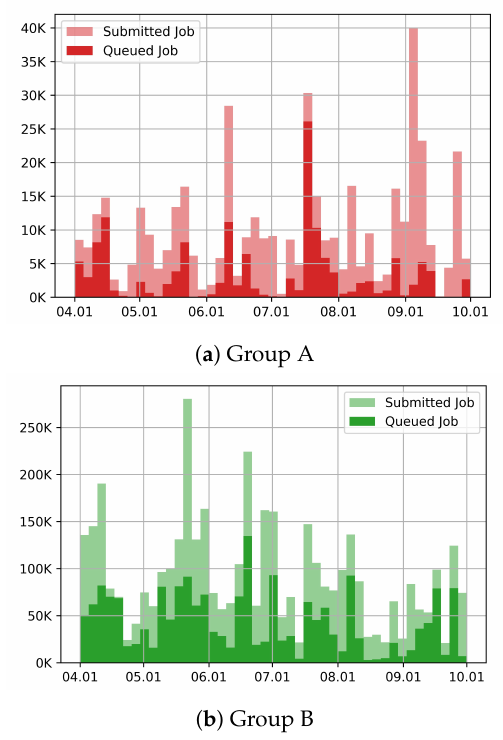
Figure 6. Submitted and queued jobs in